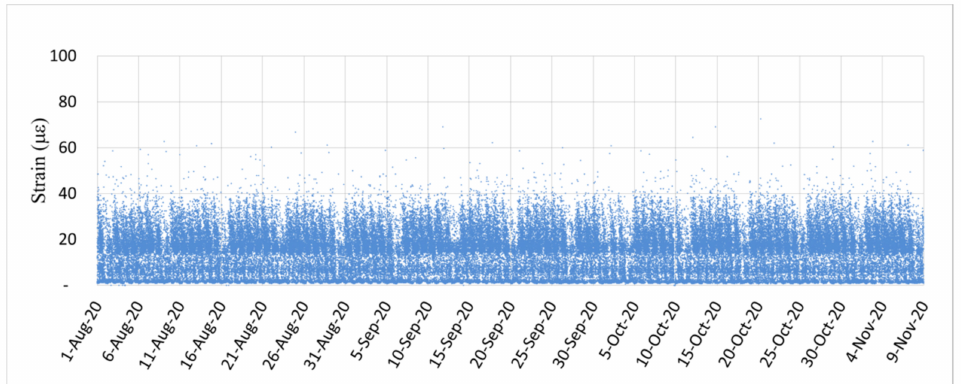
Figure 18. Dynamic strain response caused by the passage of vehicles over the fifth span of the investigated bridge.